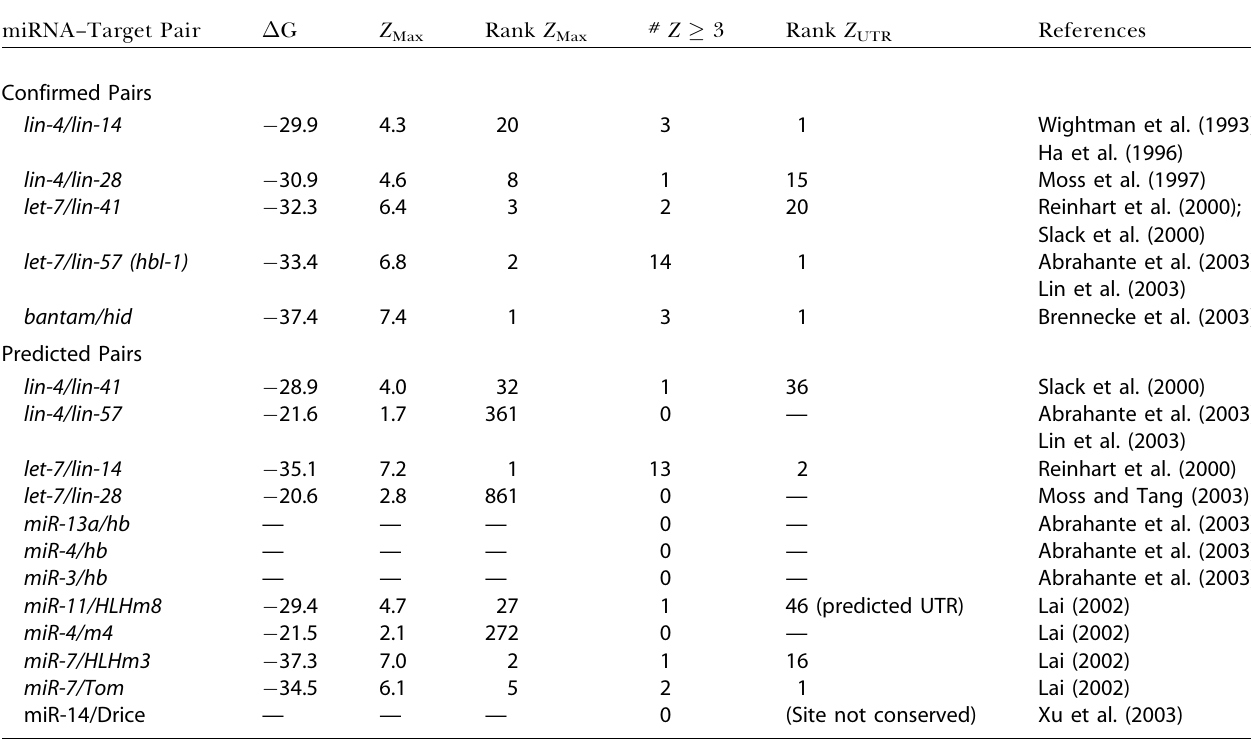
Table 1. Assessment of Predictions for Known and Predicted miRNA Targets miRNA–Target